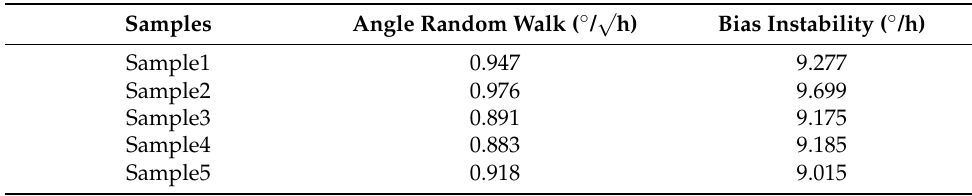
Table 2. Performance comparison results of five typical TFGs.